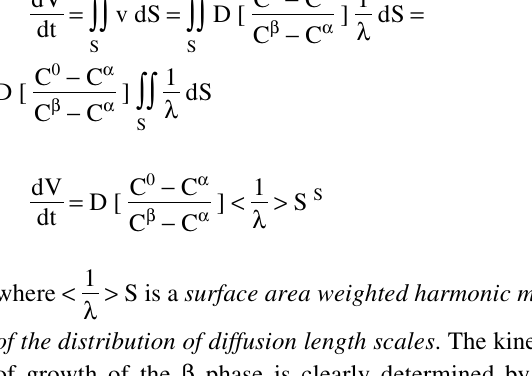
sensitive, and the supersaturation ratio obtained from the phase diagram, which may not be as sensitive to process is implicit in the distribution of diffusion length scales. If nucleation is in the site saturation mode (all of the available nucleation sites are activated at t = 0) then the distribution of diffusion length scales will be very narrow, at least until the late stages of the process where concentration interference becomes dominant. As nucleation becomes time dependent, this distribution